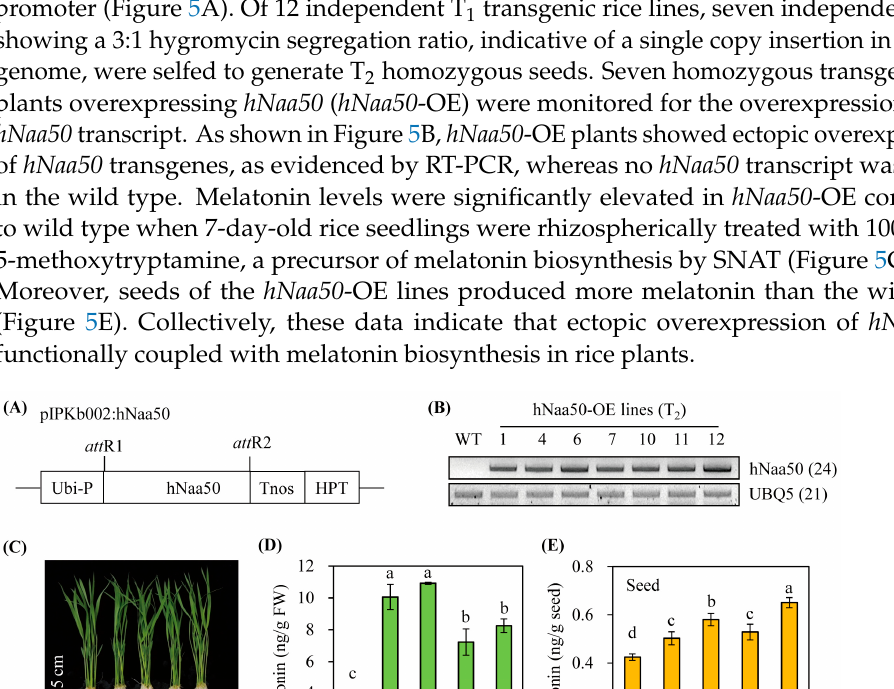
Figure 4. Localization of human Naa50. ( A ) Red fluorescence of hNaa50-mCherry. ( B ) Green fluo- rescence of cytoplasmic GFP. ( C ) Merged image ( A + B ). Leaves of 30-day-old tobacco ( Nicotiana ben-